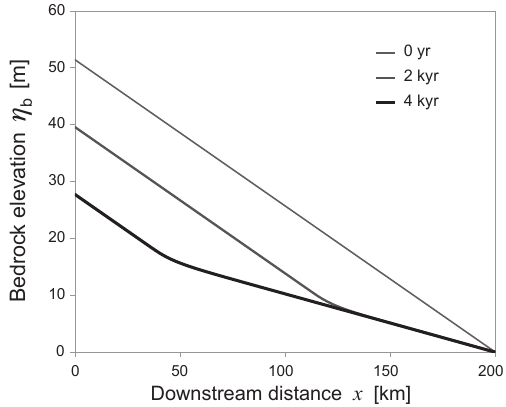
Figure 15. CSA model evolution of an initial bedrock profile to- wards a steady-state profile. Compare with the MRSAA model behavior in Fig. 16. Here η b denotes elevation of the bottom of bedrock relief, and x denotes streamwise